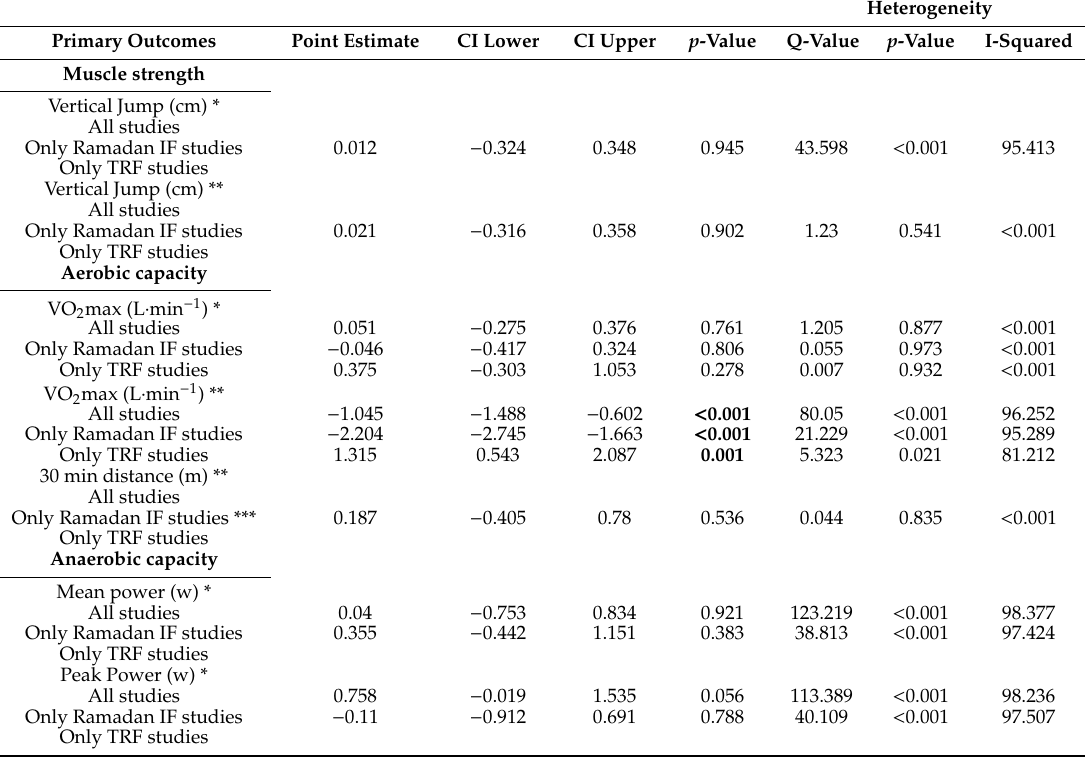
Table 3. Meta-analytic results for the e ff ects of intermittent fasting on physical performance.